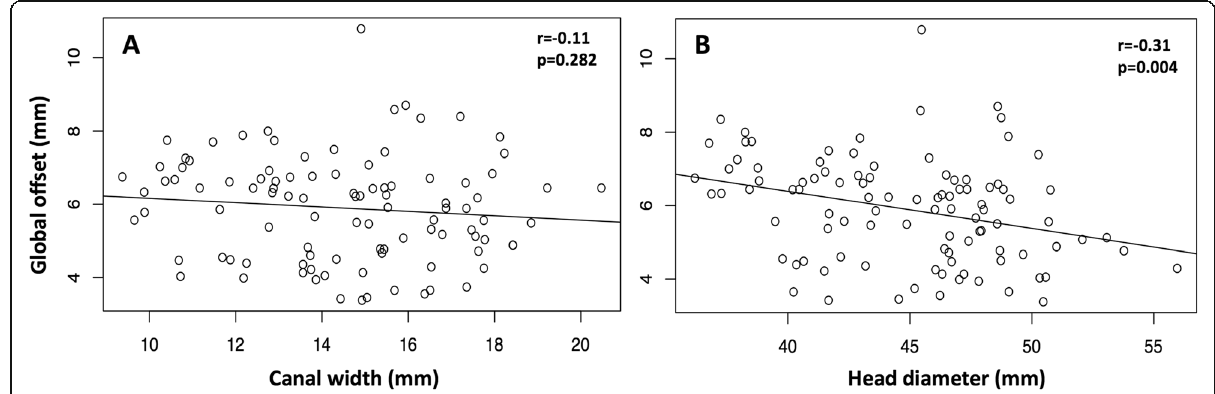
Fig. 4 Global humeral head offset for quintiles of intrameduallary canal width ( a ) and humeral head diameter ( b )